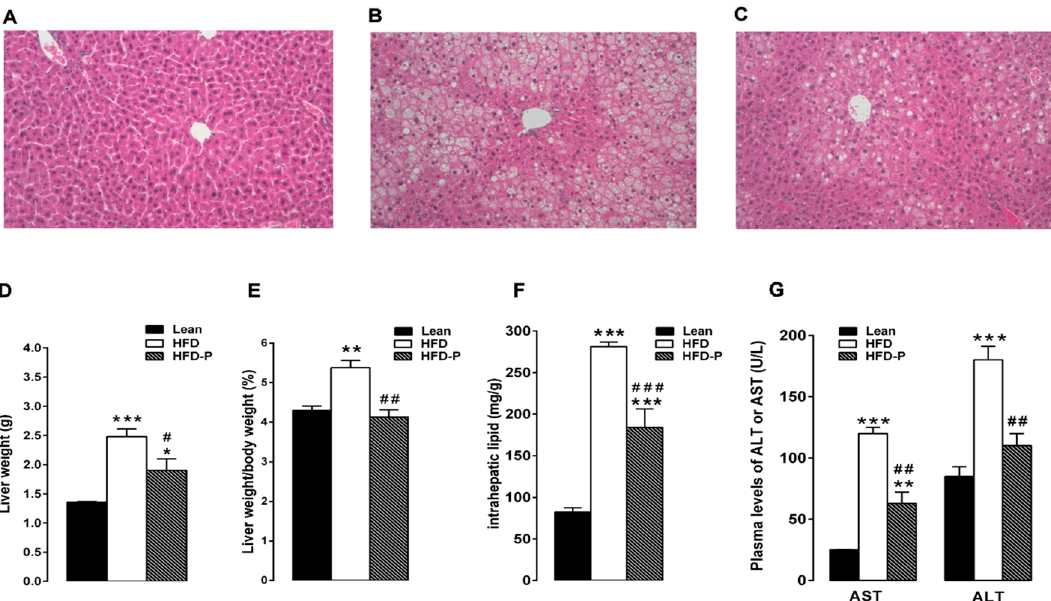
Figure 2. Pistachio consumption and liver steatosis. Pistachio diet prevents hepatic steatosis development in obese mice. Histological cross-sections of liver from lean ( A ), HFD ( B ), and HFD-P mice ( C ). Hematoxylin and eosin stain. Original magnification: × 200. Liver weight ( D ), liver weight/body weight ratio ( E ), intrahepatic lipid content ( F ), and plasma levels of AST and ALT ( G ) in lean, HFD, and HFD-P mice. Data are the means ± S.E.M. ( n = 8/group). Asterisk denotes significant difference compared with the lean group (* p < 0.05; ** p < 0.01; *** p < 0.001); hash denotes significant difference compared with the HFD group ( # p < 0.05; ## p < 0.01; ### p < 0.001;).